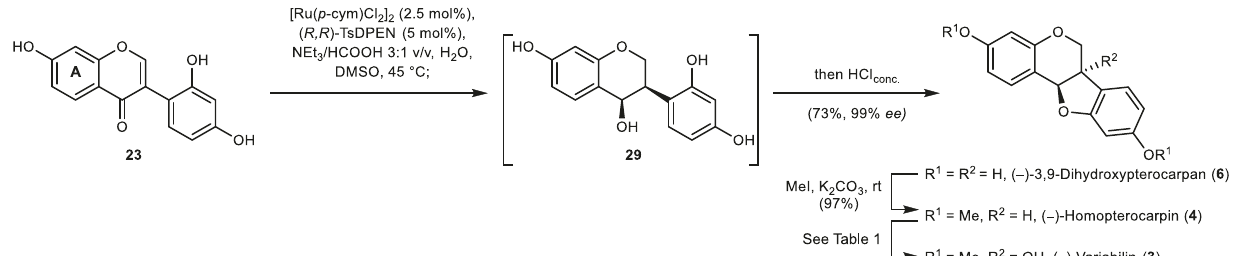
Fig. 7 Second-generation synthesis of ( − )-variabilin (3). ATH cascade and cyclisation from the globally deprotected iso fl avone 23 to give ( − )-3,9- dihydroxypterocarpan ( 6 ), methylation to ( − )-homopterocarpin ( 4 ), and conversion of 4 to ( − )-variabilin ( 3